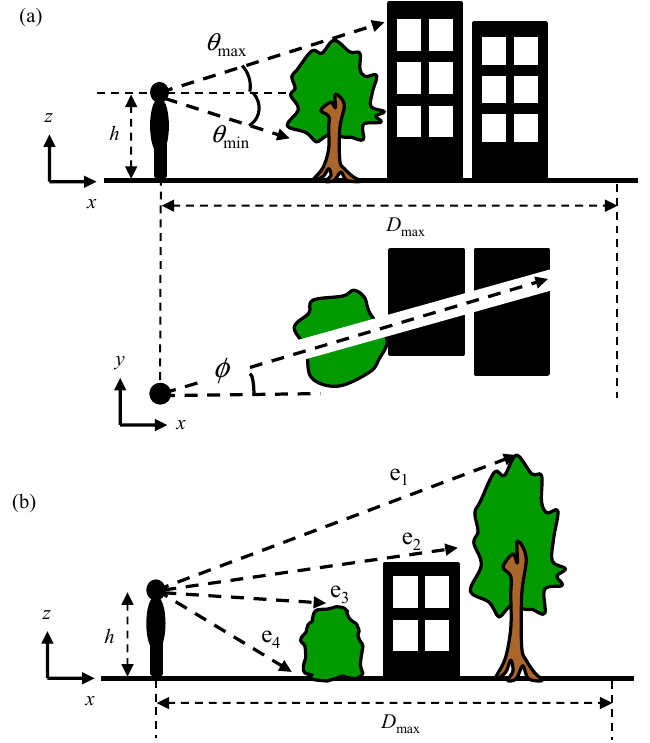
Figure 2. Maximum elevation angle θ max at which occlusion by vegetation is present from the viewpoint of a human of height h along azimuth φ within the maximum range D max . ( a ) Minimum elevation angle θ min is estimated by referring to the ground surface height of a point where θ max is observed in the case where no object exists between the human and vegetation. ( b ) In the case where multiple populations of vegetation exist, maximum and minimum elevation angles occluded by each one are examined. In ( b ), e 1 and e 3 denote the eye sights at the maximum elevation angles, whereas e 2 and e 4 denote the eye sights at the minimum elevation angles.